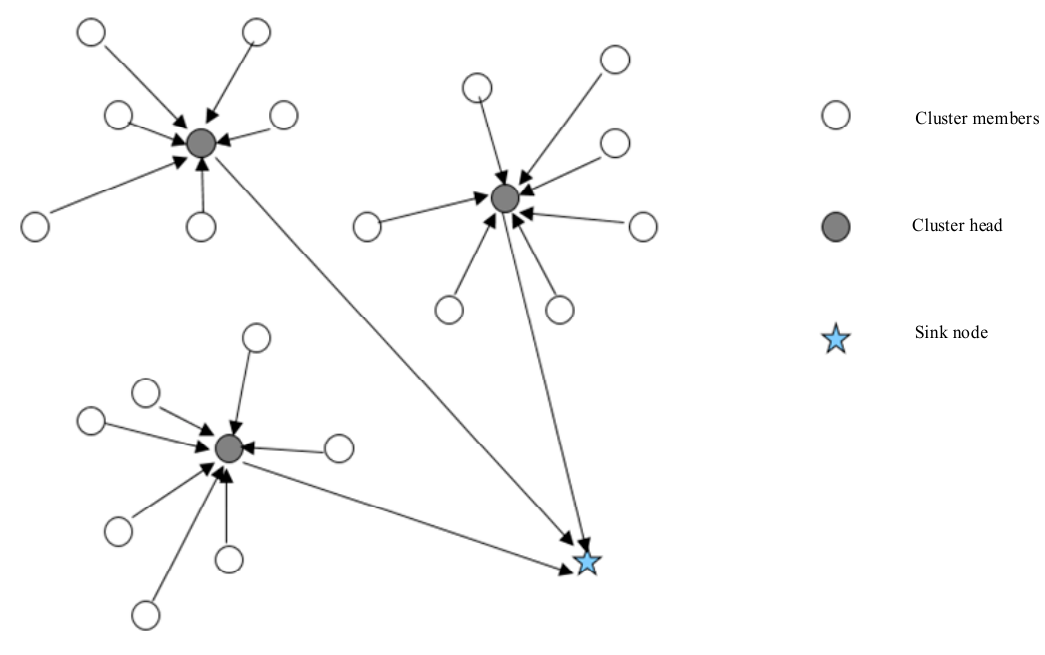
Figure 3. Data fusion in hierarchical routing.